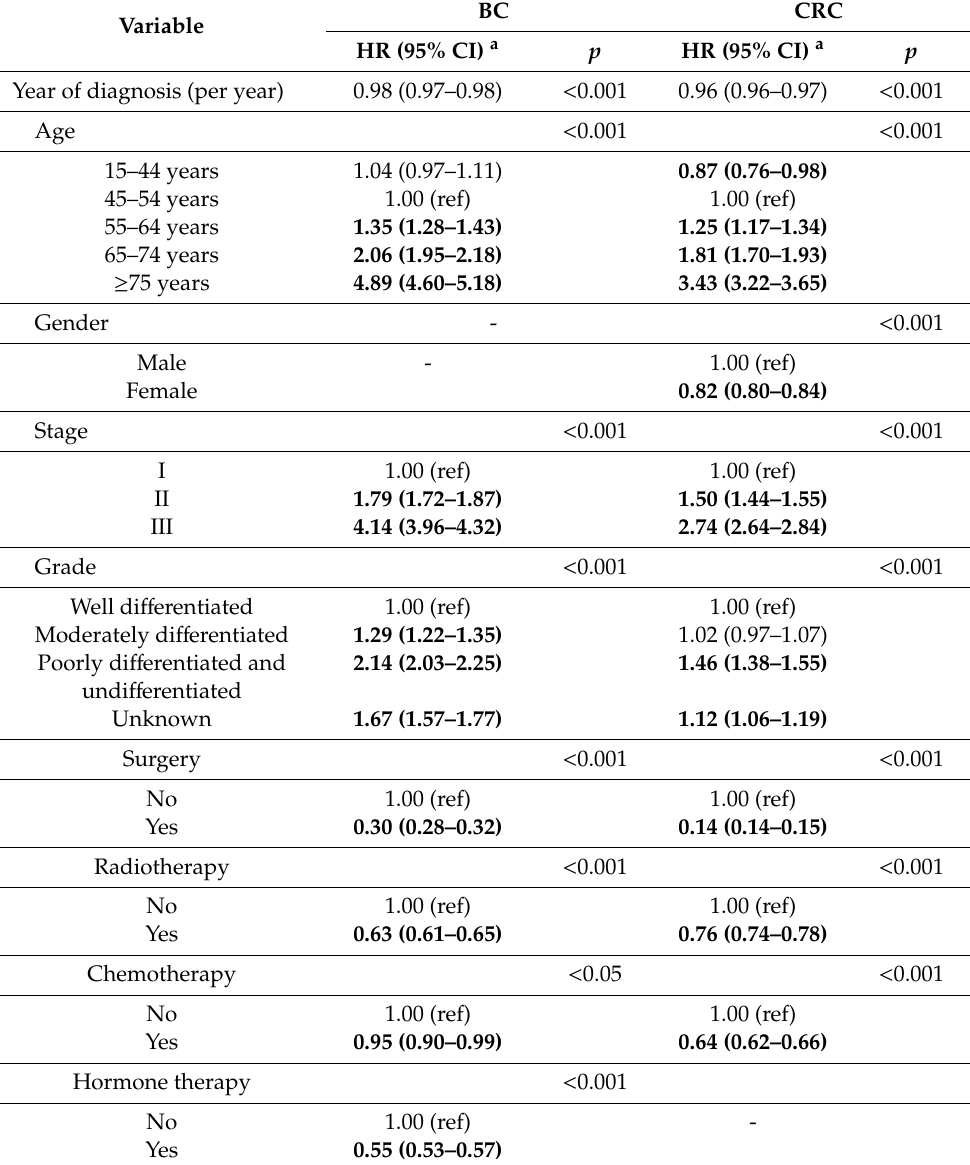
Table 2. Multivariate Cox hazard analysis of five-year overall